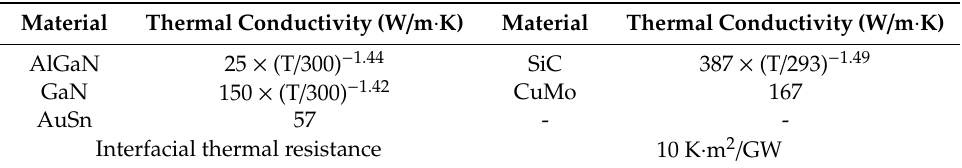
Table 2. Thermal parameters used in the